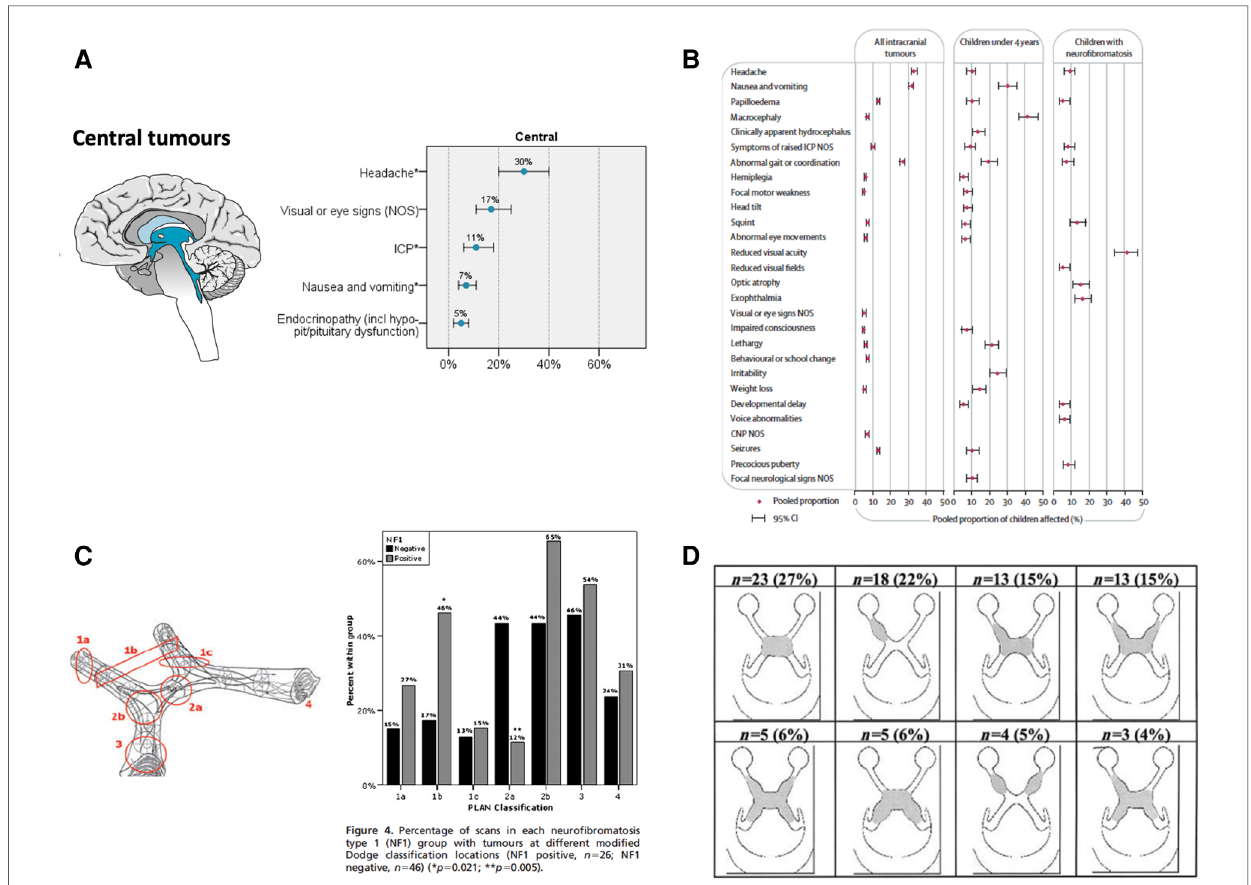
FIGURE 1 ( A ) Symptomatology of supratentorial/midline (central) tumors of childhood (3). ( B ) Comparison of brain tumor symptomatology for those with and without NF1 (11). ( C ) Comparison of anatomical distribution of OPHG between sporadic and NF1 types using the Modi fi ed Dodge Classi fi cation/PLAN Score (42). ( D ) Anatomical distribution of NF1 OPG in the multi-centre NF1 clinic cohort